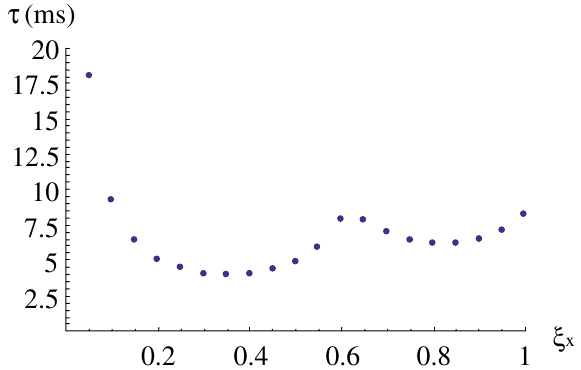
FIG. 12. (Color) Dependence of the horizontal head-tail insta- bility rise time on the horizontal chromaticity (cid:23) theoretical model of the